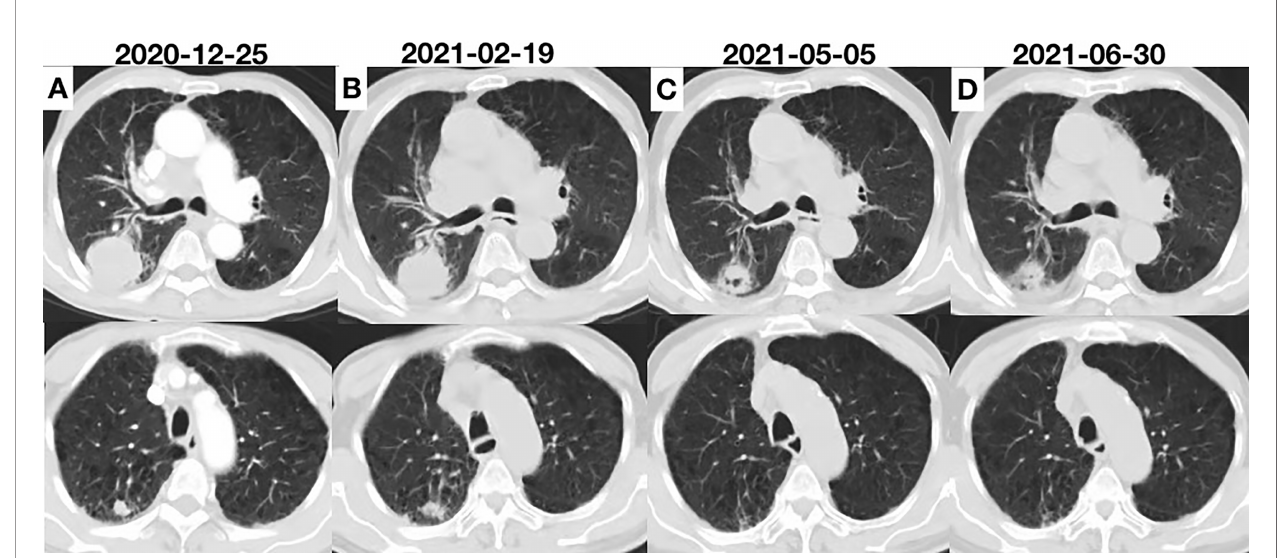
FIGURE 3 | (A) Chest computed tomography (CT) scan showing the initial tumor. (B) Two cycles after anlotinib initiation; the ef fi cacy was evaluated as SD. (C) CT scan showing remarkable shrinkage of the tumor; the ef fi cacy was evaluated as PR. (D) CT scan showing sustained shrinkage of the tumor and a small amount of additional effusion; the ef fi cacy was evaluated as